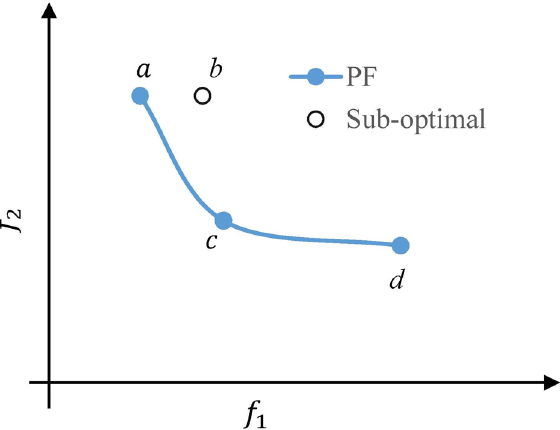
Figure 5. Concept of Pareto dominance for bi-objective functions ( f 1 and f 2 ) optimization minimization